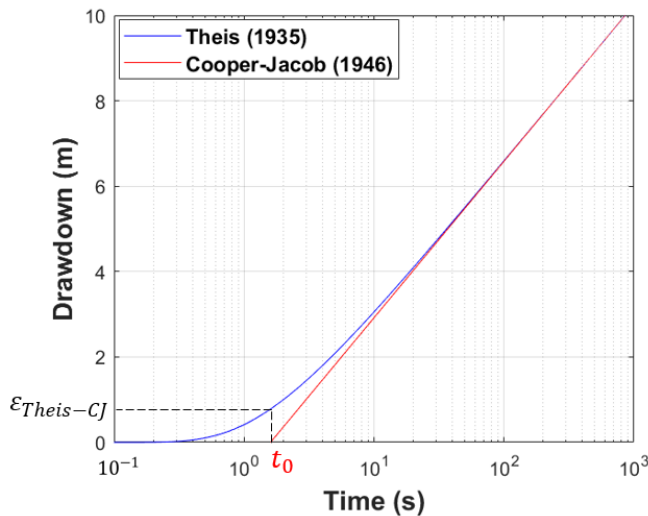
Figure 3. Illustration of simulated drawdown curves predicted by Theis and CJ models at r = 6 m for a pumping test with Q = 0.2 m 3 /s, T = 0.01 m 2 /s and S = 0.001 .